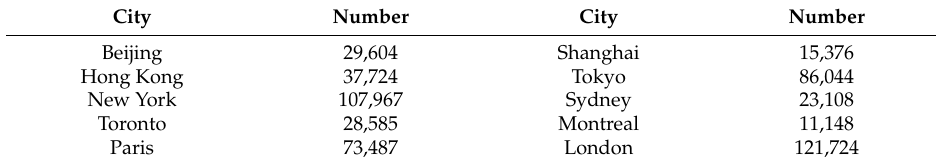
Table 2. Total number of samples for each